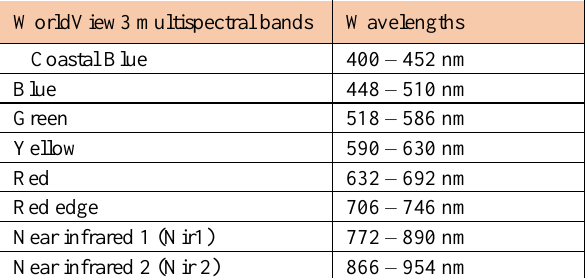
Table 3 . Multispectral bands captured by the WorldView3 satellite and their respective